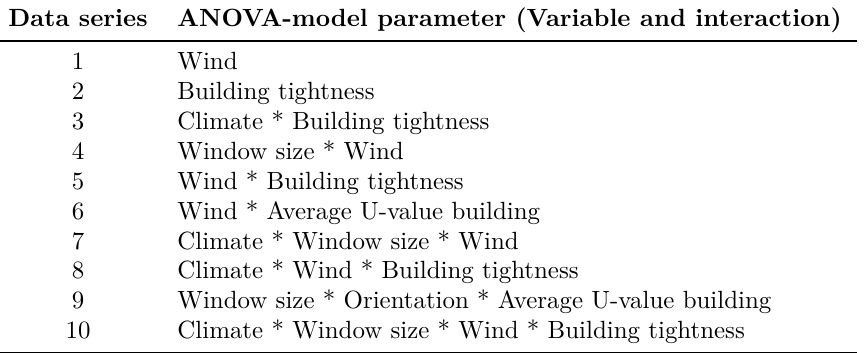
Table 3. Selected data series with model parameters.